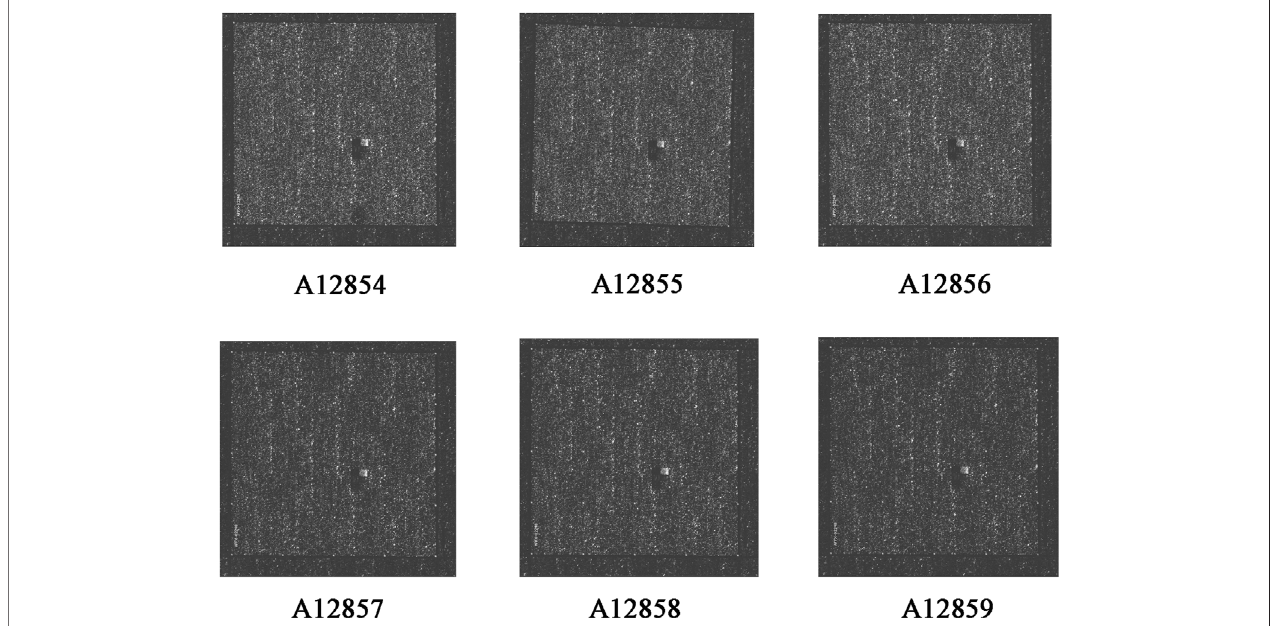
FIGURE 3 | Signal intensity pro fi les of the samples. Notes: Normal group: A12854, A12855, and A12856; Medication group: A12857, A12858, and A12859.